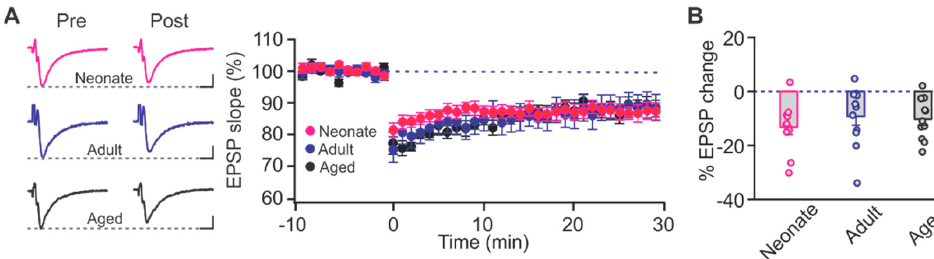
Figure 2. Long-term depression (LTD) in the piriform cortex layer Ib. ( A ) Example traces and time courses of fEPSPs with LTD inductions in neonate, adult and aged animals. n = 11 for each age group. Scale bars, 0.5 mV, 5 msec. ( B ) Percentage changes of fEPSPs at 30 min post-induction.